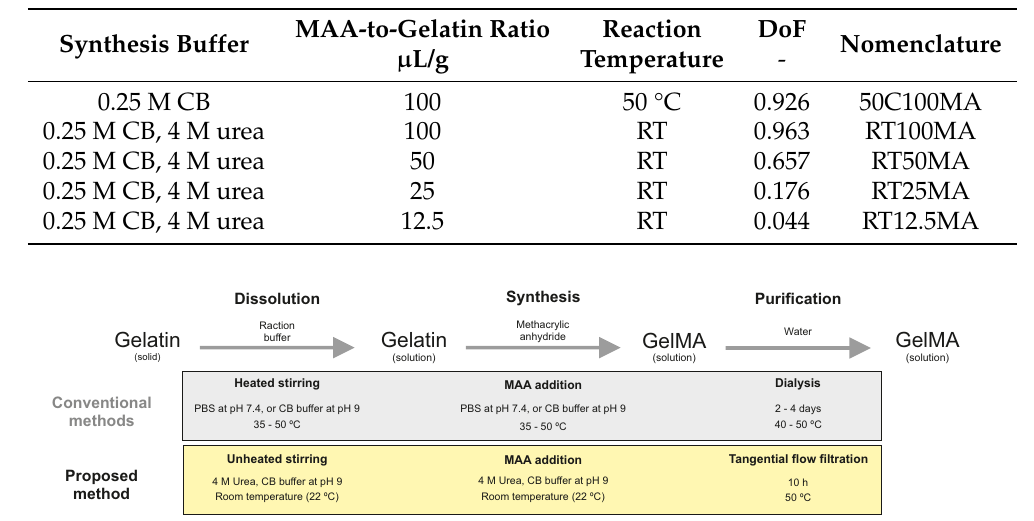
Table 1. Overview of the experimental set-up for the synthesis of gelatin methacryloyl (GelMA), and the sample nomenclature used throughout this manuscript. CB: carbonate-bicarbonate, DoF: degree of functionalization RT: room temperature.